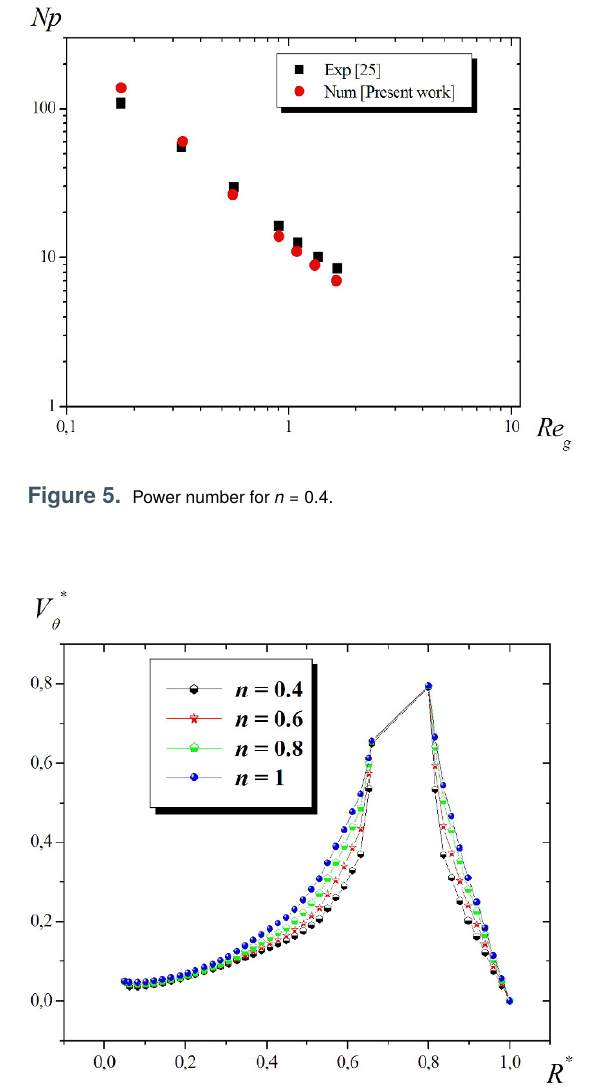
Figure 4. Tangential velocity for n = 1.